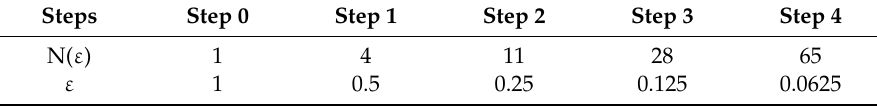
Table 1. The change of N( ε ) versus di ff erent values of ε for the example in Figure 5.